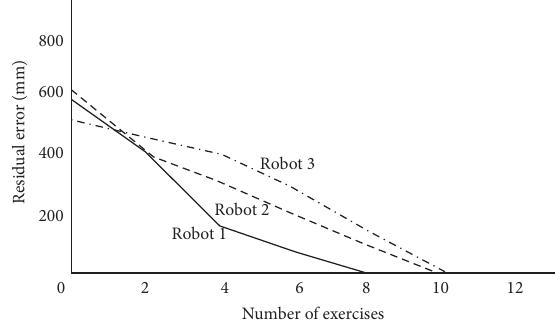
Figure 9: Control error test of this